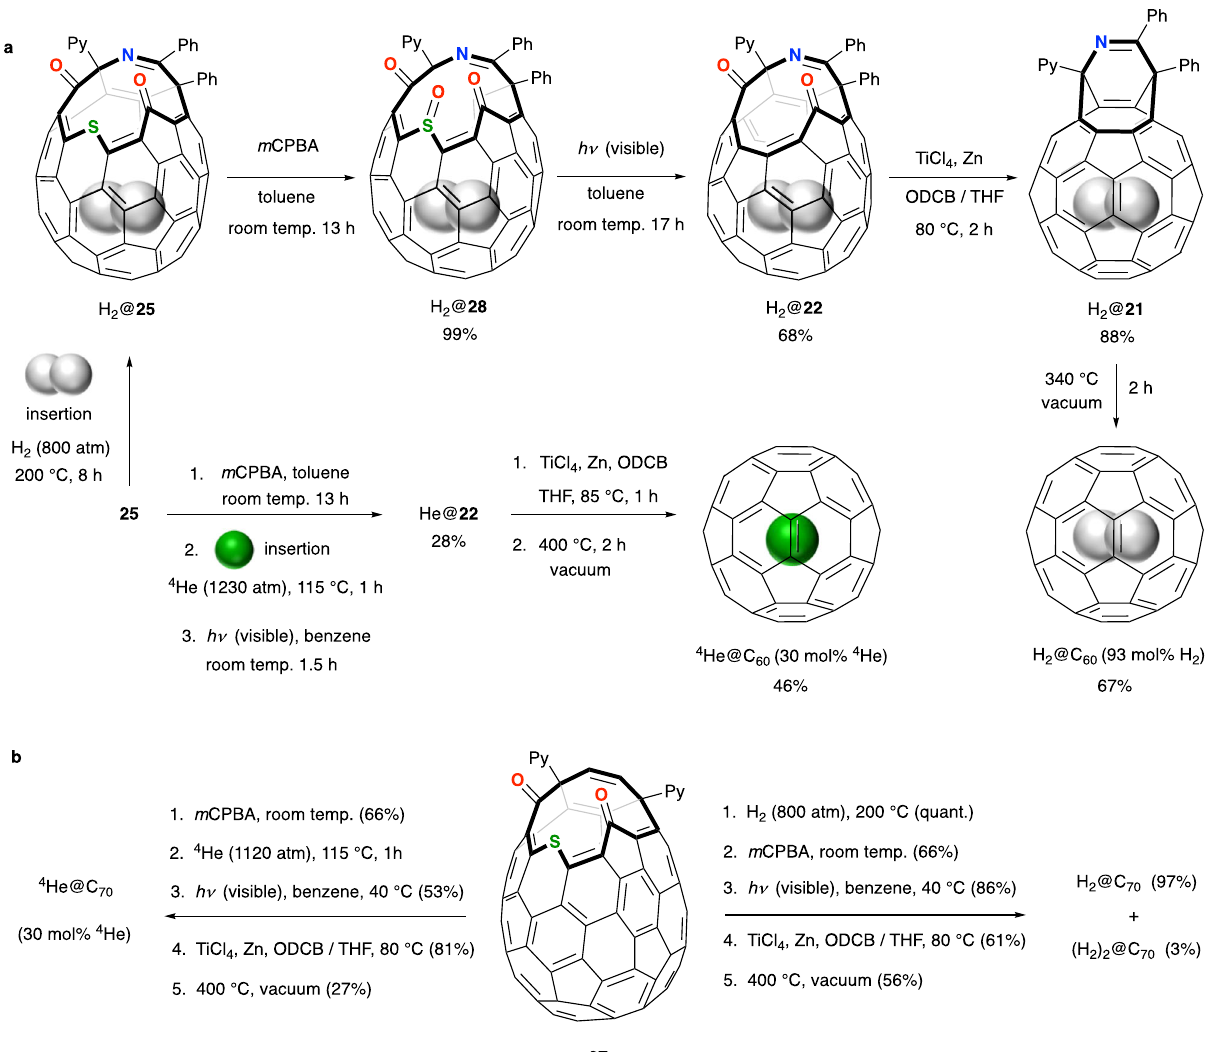
Fig. 4 Komatsu ’ s synthesis of H 2 @C 60/70 and 4 He@C 60/70 . a Synthesis of H 2 @C 60 and 4 He@C 60 via sul fi de oxidation and photochemical desul fi nylation, each at ambient temperature. The order of steps is altered to avoid an intermediate 4 He@ 25 from which escape of helium is very facile. b Synthesis